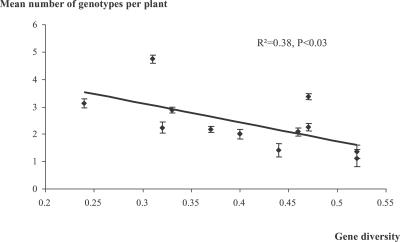
Mean Number of Parasite Genotypes per Plant (± SE) Plotted against the Genetic Diversity within Populations